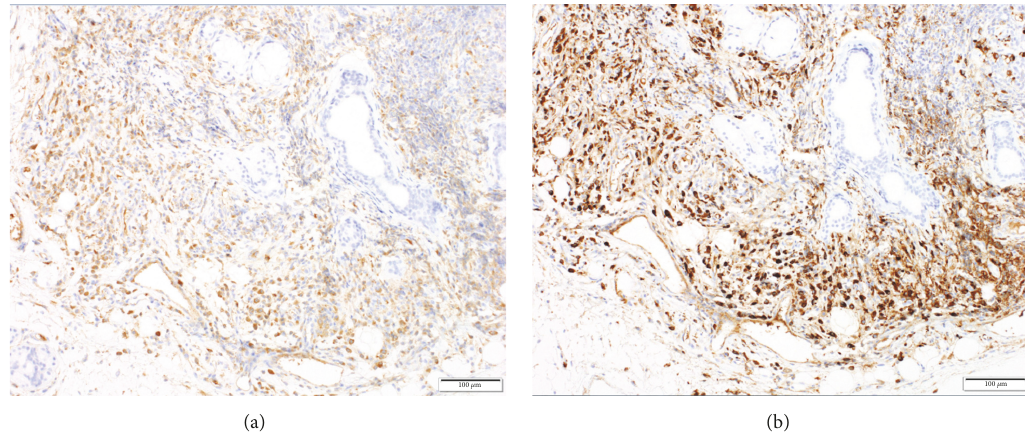
Figure 2: Pathology of the parotid gland at the diagnosis of IgG4-RD. (a) IgG staining and (b) IgG4 staining. There are many plasma cells stained with IgG (a) and 90% of them were positive for IgG4 (b). IgG4-RD, IgG4-related disease; IgG, immunoglobulin